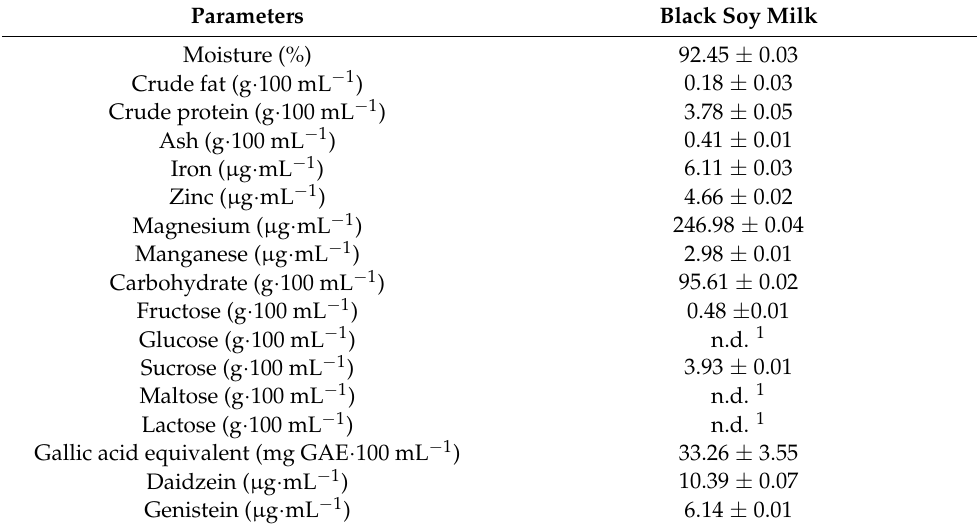
Table 2. Chemical properties of black soy milk.